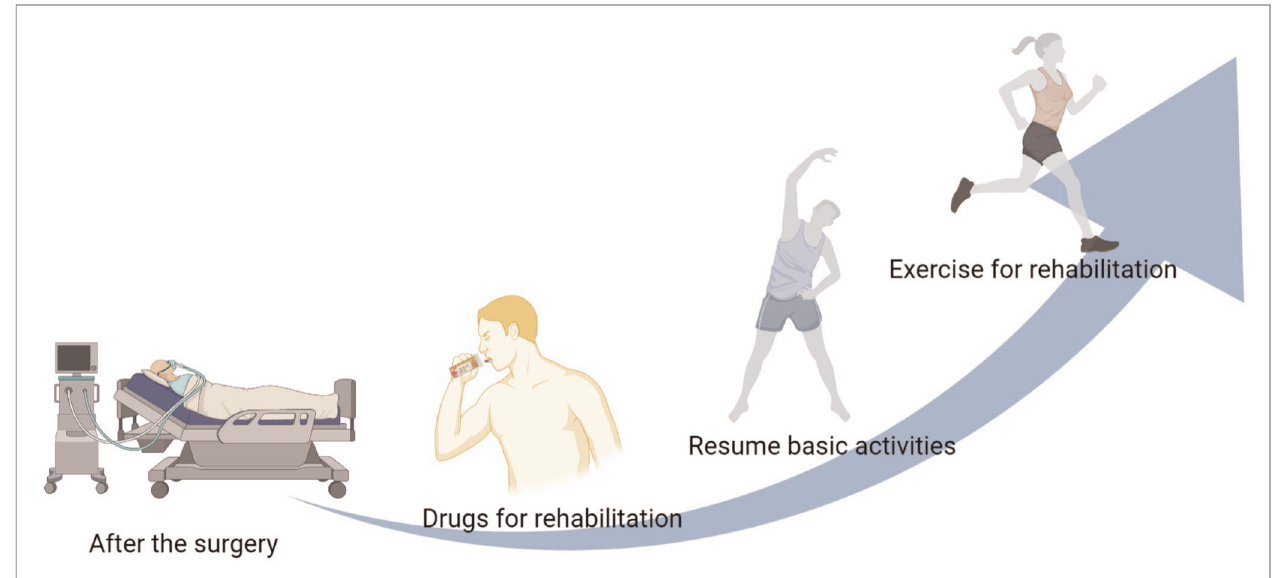
FIGURE 1 | Postoperative rehabilitation